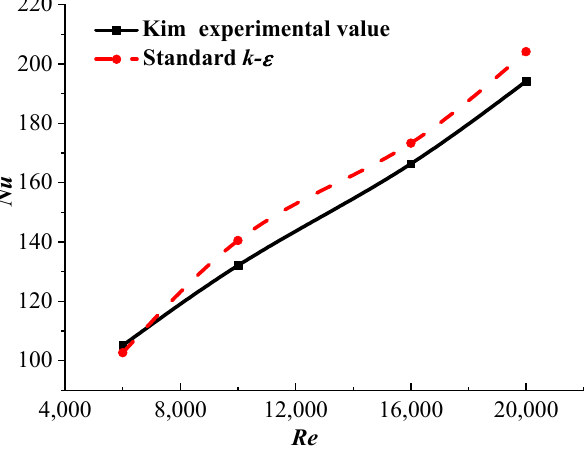
Figure 12. Validation of